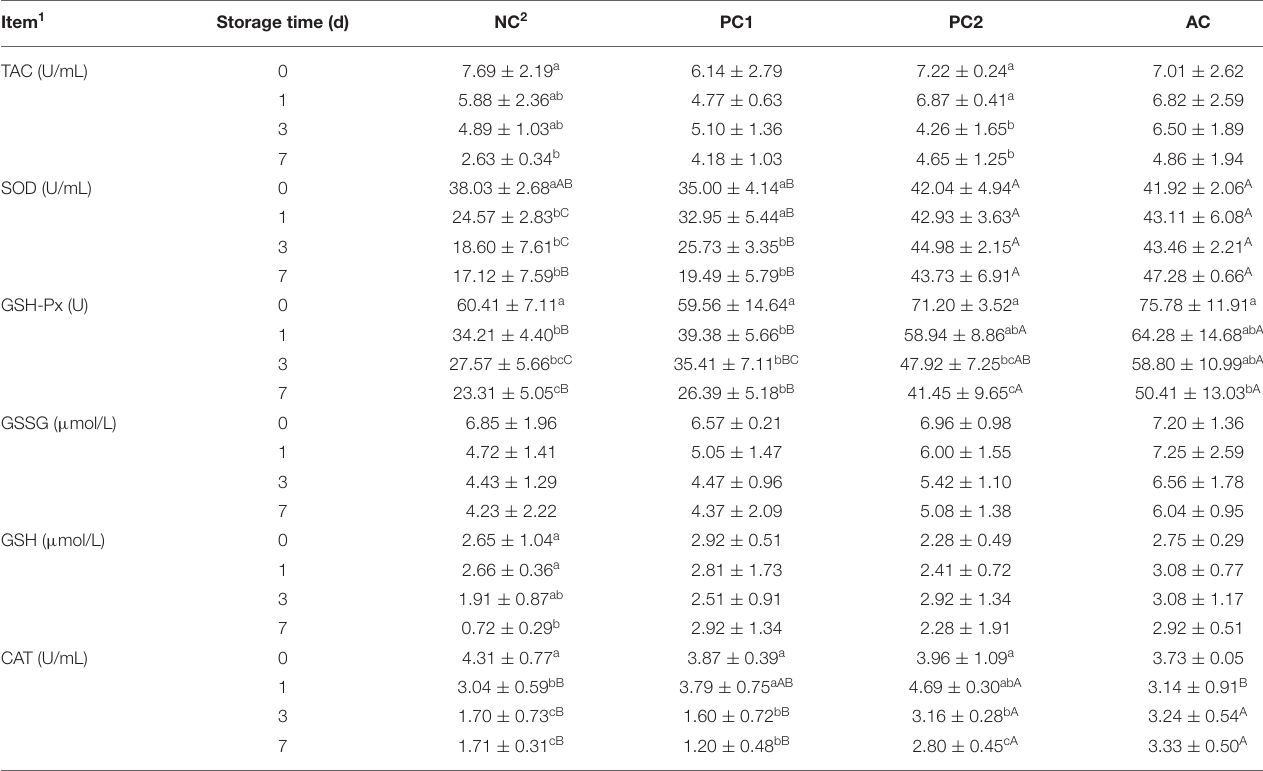
TABLE 2 | Effect of PCP on antioxidant capacity in milk during storage